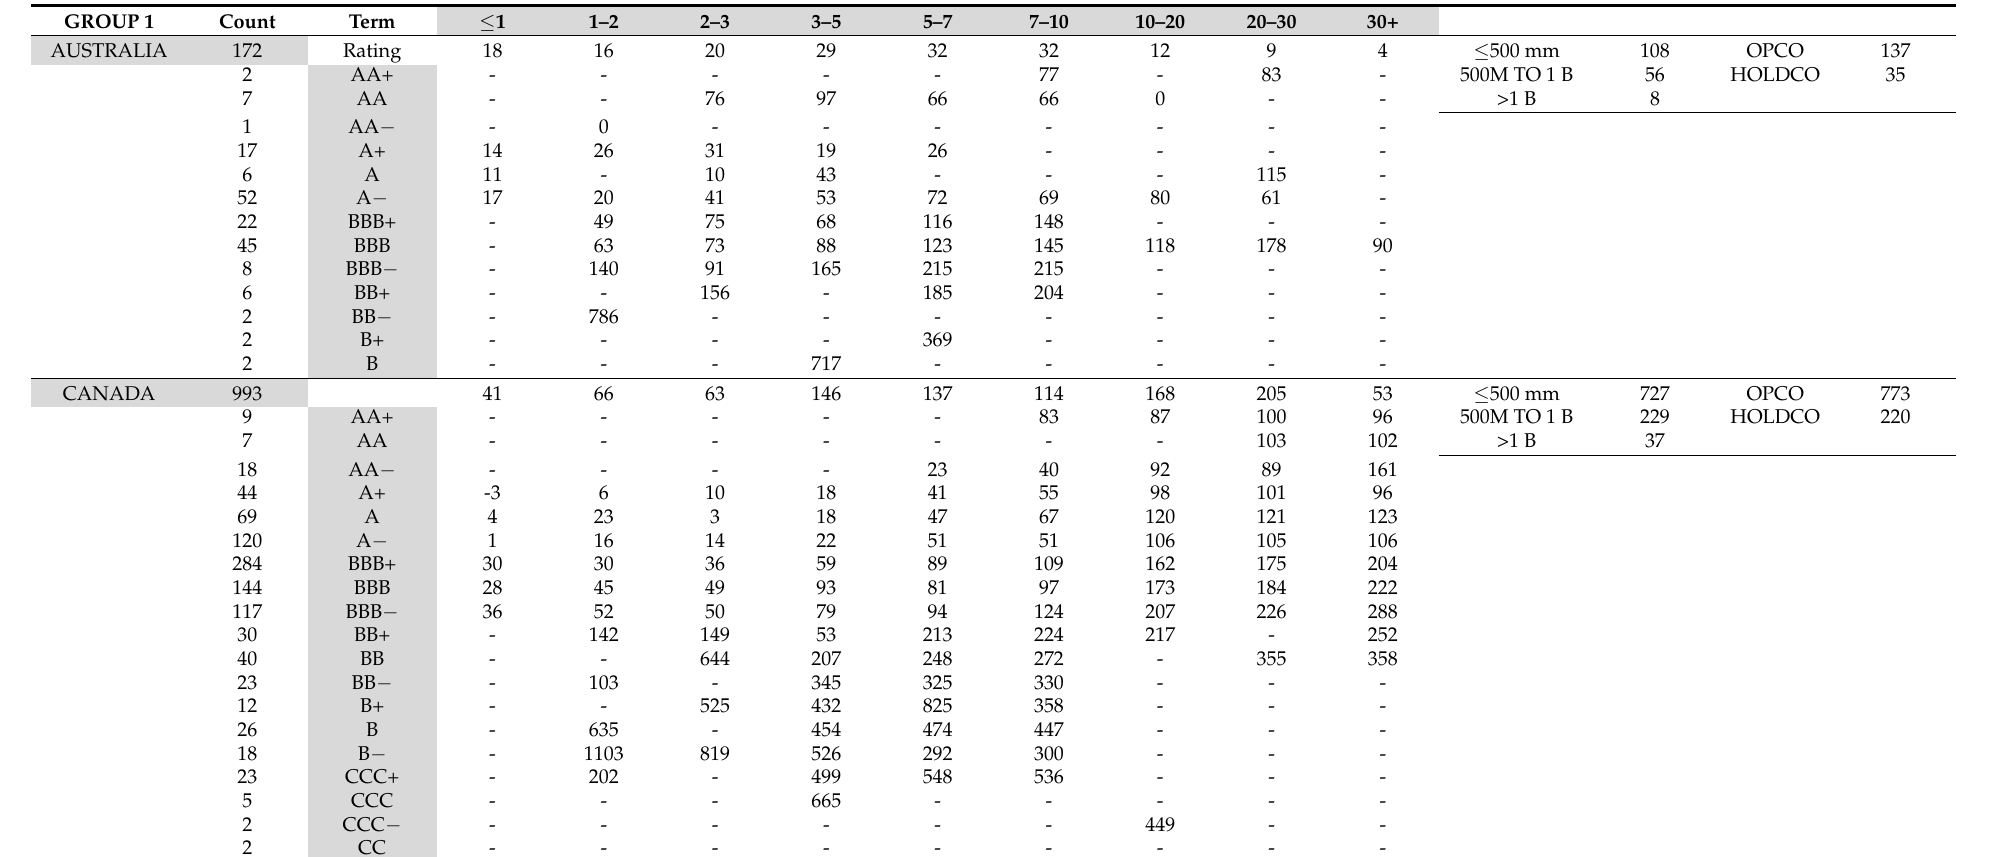
Table 3. G20—Group 1—Corporate credit spreads with S&P ratings and terms to maturity, issue amount, and the business structure of the issuer. Adding